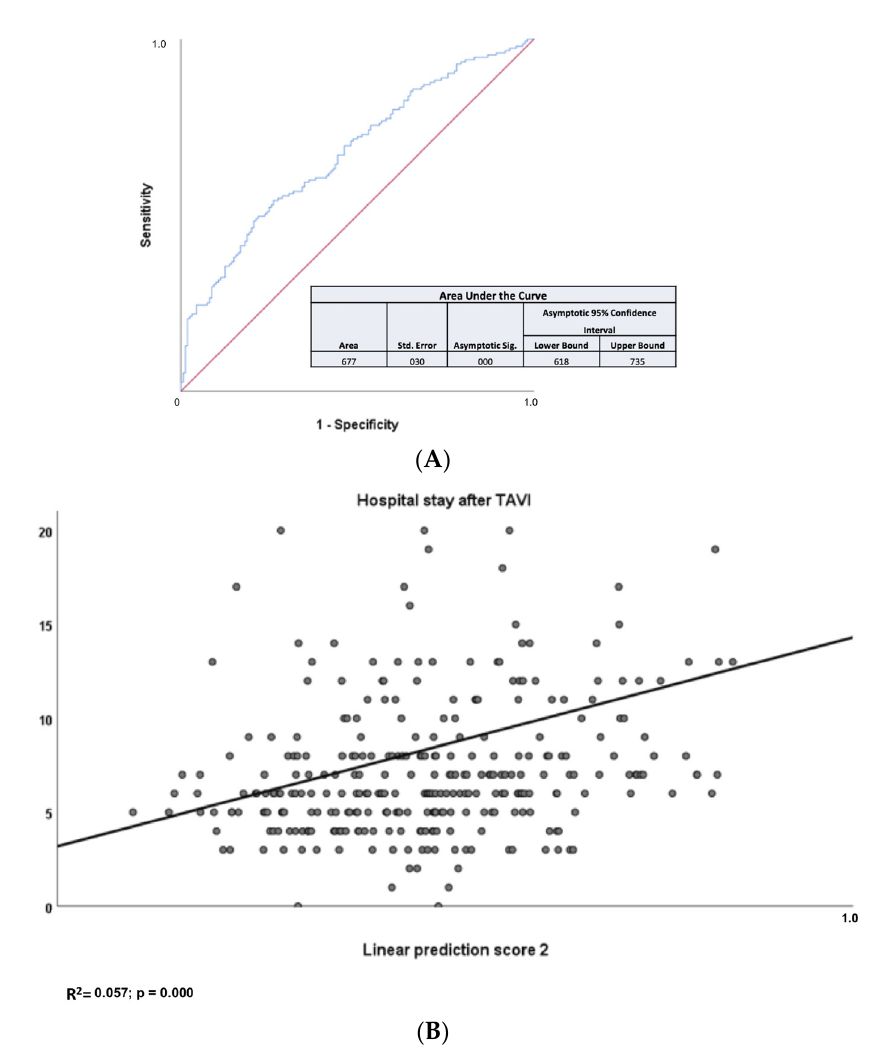
Figure 2. ( A ) Area under the ROC curve for the calculated LPS 2 for the secondary endpoint LoS. The calculated linear prediction score (LPS) 2 provided an area under the ROC curve of 0.667 ( p < 0.001; 95% confidence interval 0.618–0.735). ( B ) Values for the secondary endpoint LoS as a function of LPS 2. Calculation of linear prediction score (LPS) 2 based on baseline levels of eGFR based on cystatin C and NTproBNP and EQ5D5L score allowed evaluation of LoS (R 2 = 0.057; p <